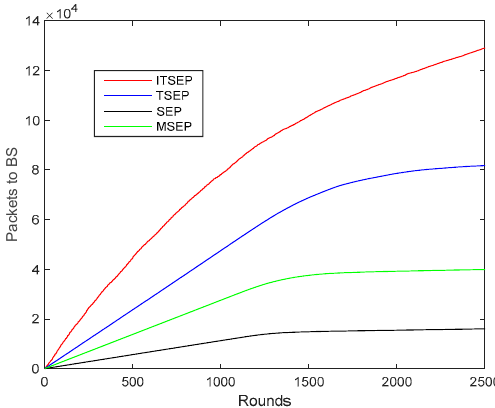
Figure 4. Throughput. ITSEP: Improved Threshold-Sensitive Stable Election protocol; TSEP: Threshold-Sensitive Stable Election Protocol; SEP: Stable Election Protocol; MSEP: Modified Stable Election Protocol.